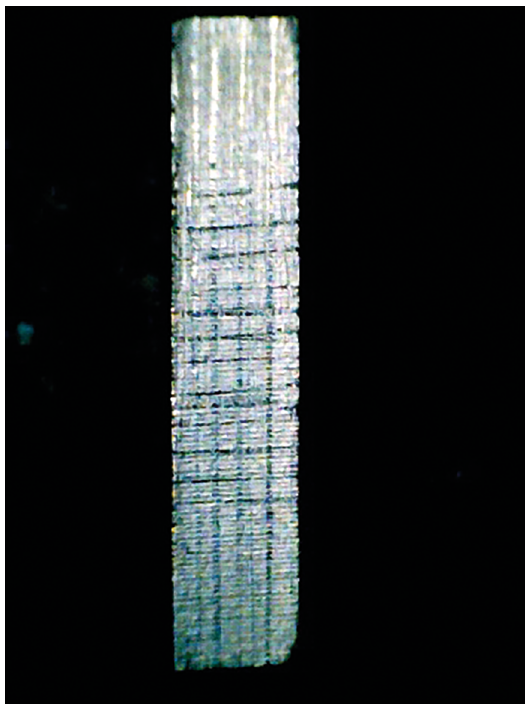
O composites of cast iron 2 3